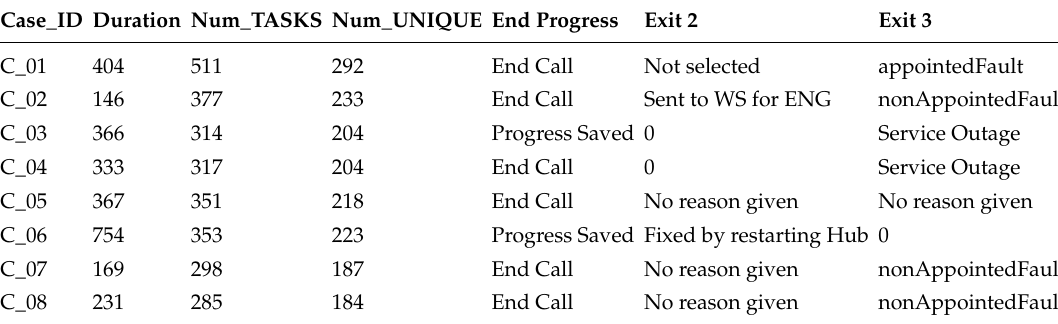
Table 4. Table representing sample values of features for each individual case.